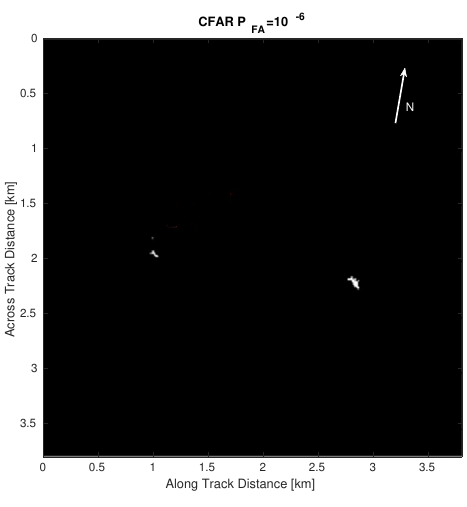
Figure 16. W-CFAR output.